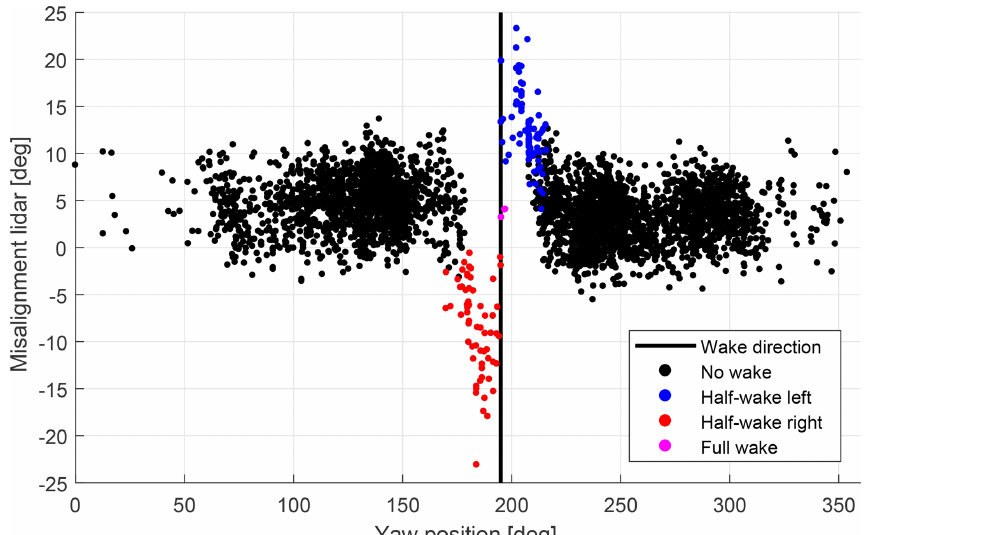
Figure 9. Lidar-estimated 10min mean yaw misalignment b φ as function of turbine yaw position. The vertical black line indicates the position of the upstream Nordtank turbine. Detected waked situations are shown as coloured